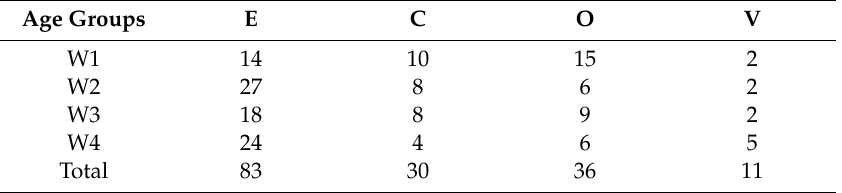
Table 1. Stratification of patients according to type of gynaecological malignancy and